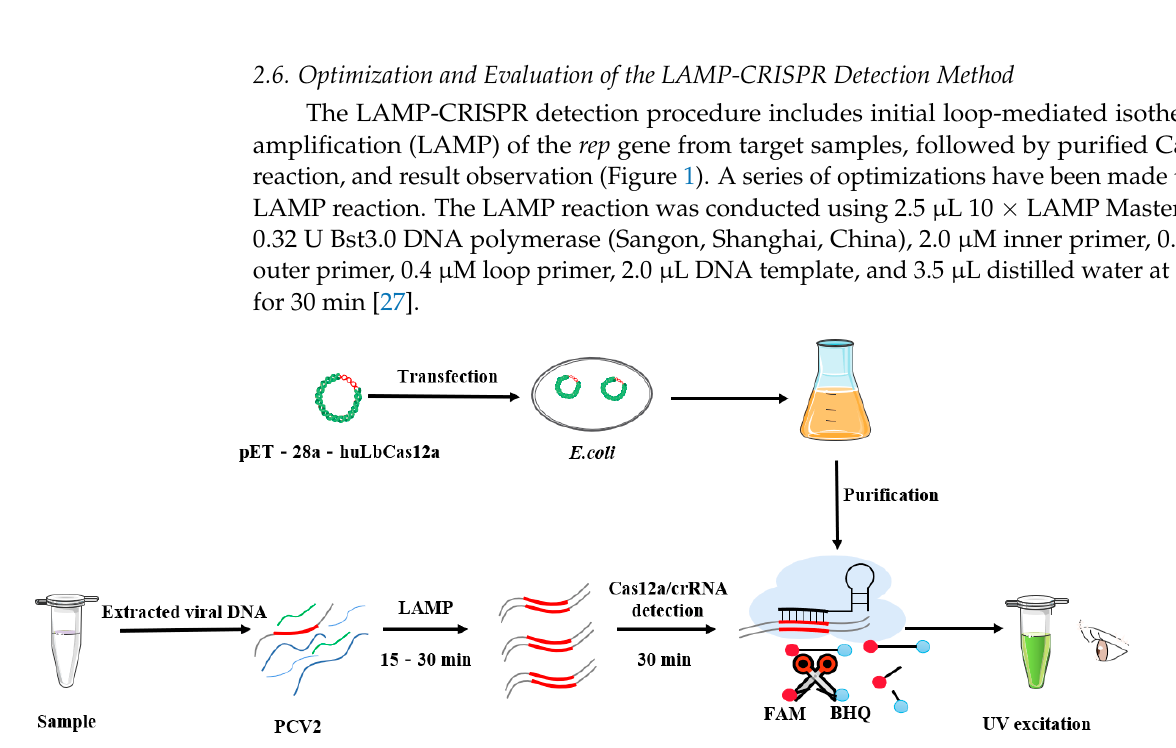
Figure 1. Schematic of LAMP amplification, hubLCas12a protein preparation and Cas12a/crRNA cleavage for visualizing the presence of PCV2-specific nucleic acids.